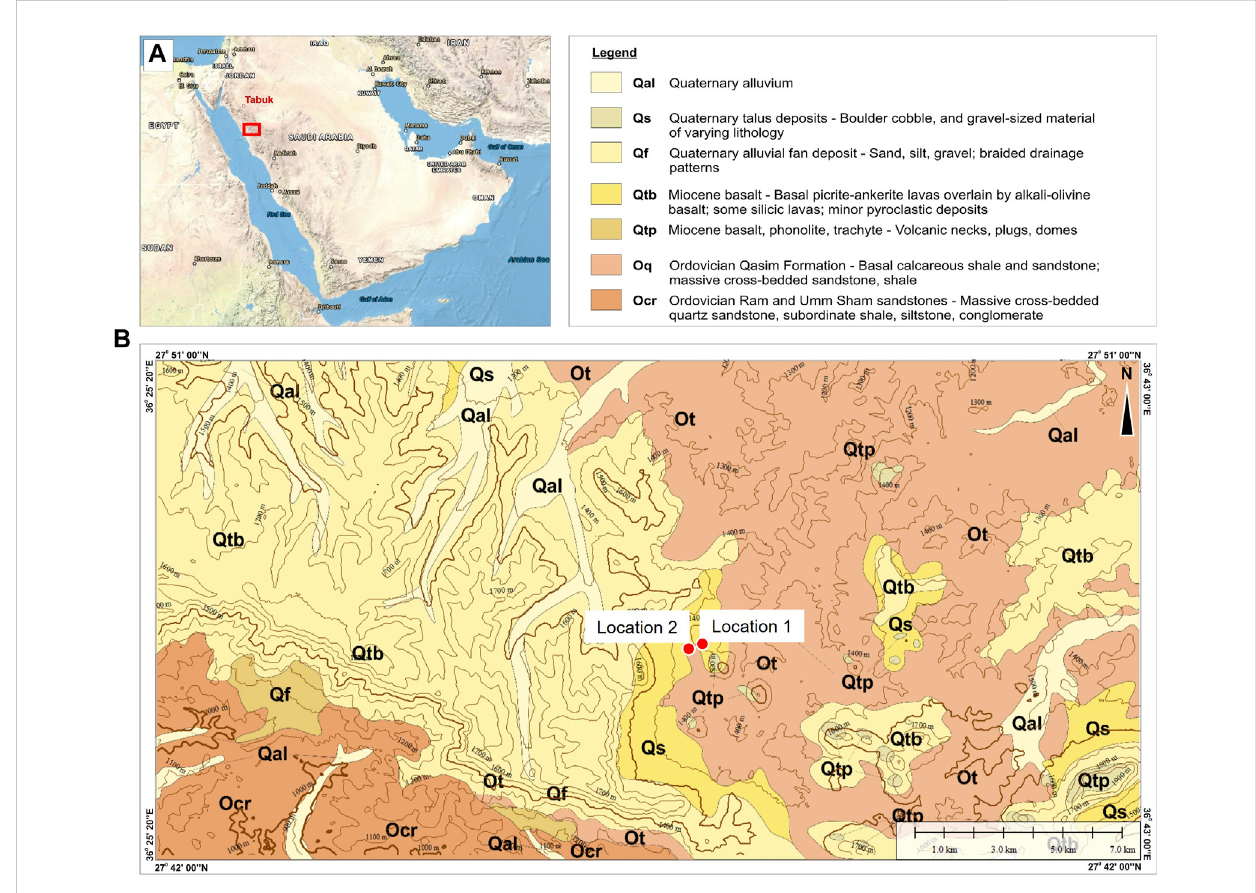
FIGURE 1 Location map ofthe study area. (A) Map ofSaudiArabia showingthe study area (redbox). (B) Simpli fi edgeologicalmap showing thelocations ofthe studied outcrops.